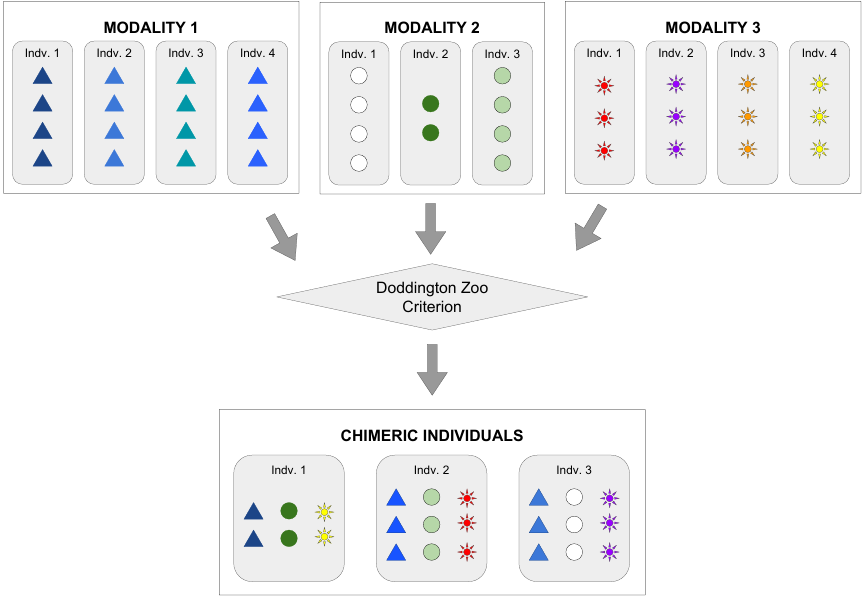
Figure 5. The process to combine modalities and create the chimeric individual is a stochastic process, respecting the constraints presented in Section 4.3. The figure illustrates the process of creating chimeric individuals of one specific Doddington Zoo